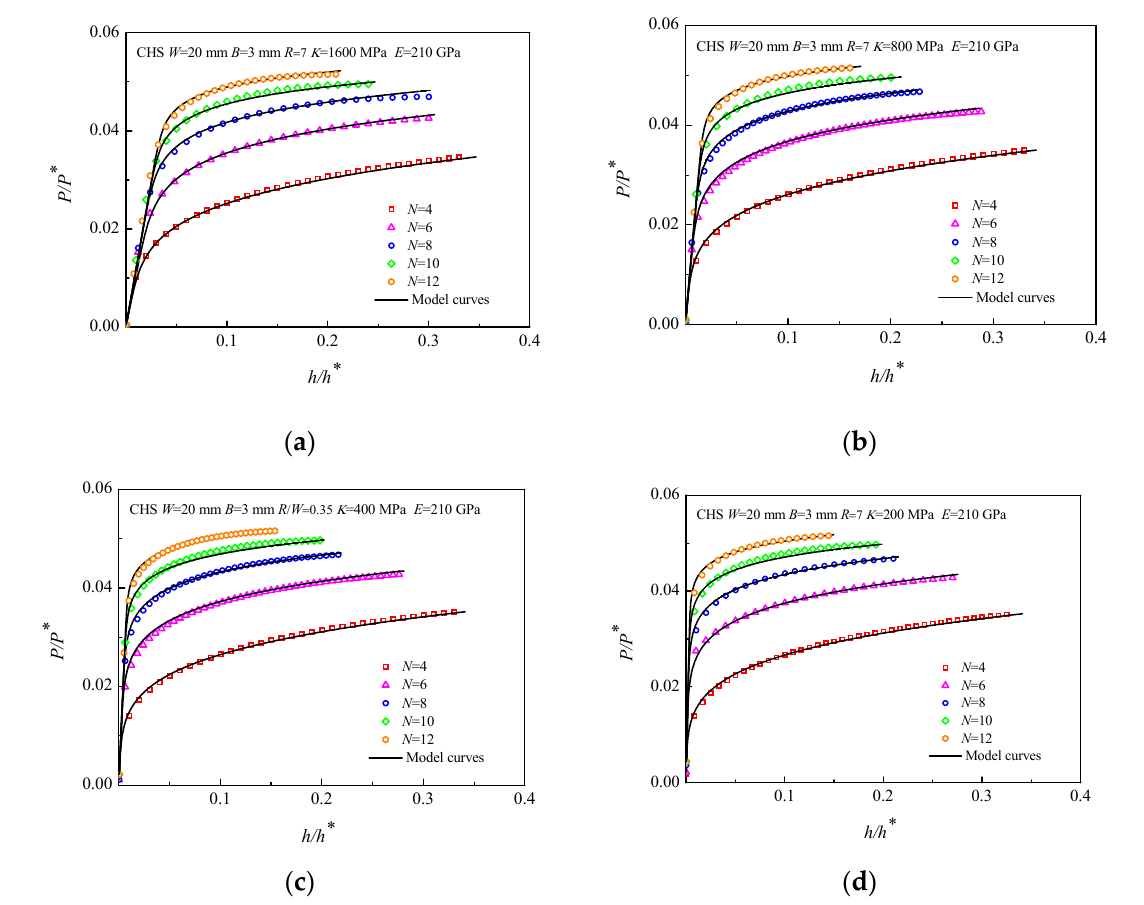
Figure 6. P/P* ~ h/h * curves of the CHS specimens with strain hardening exponent N , ( a ) K = 1600 MPa E = 210 GPa; ( b ) K = 800 MPa E = 210 GPa; ( c ) K = 400 MPa E = 210 GPa; ( d ) K = 200 MPa E = 210 GPa.